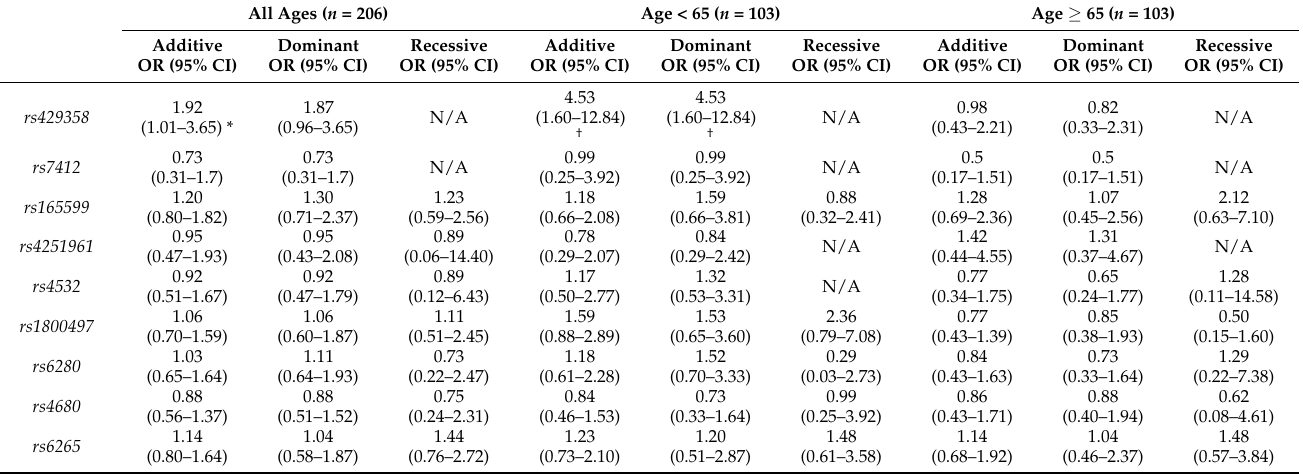
Table 2. AnalysisofAPOE4( rs429358